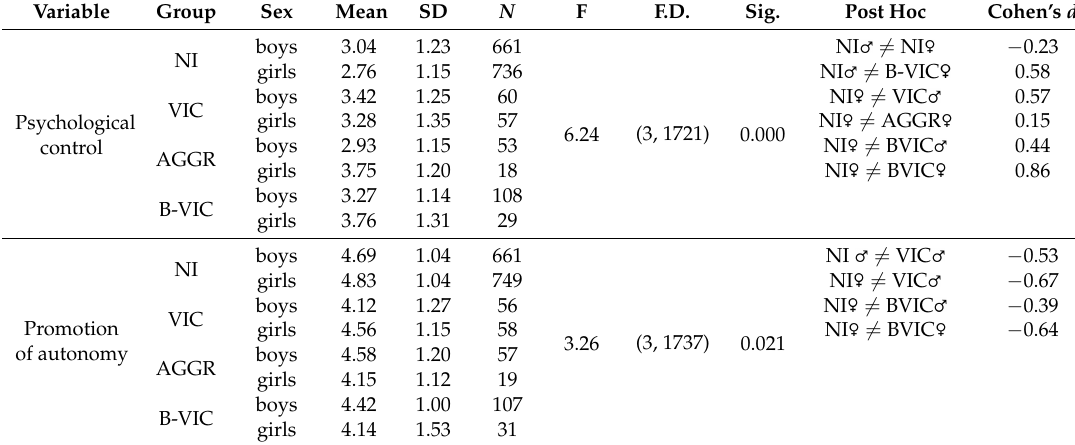
Table 5. Two-way ANOVAS about the differences in father parenting practices according to the interaction between the role of involvement in cyberbullying and gender. Variable